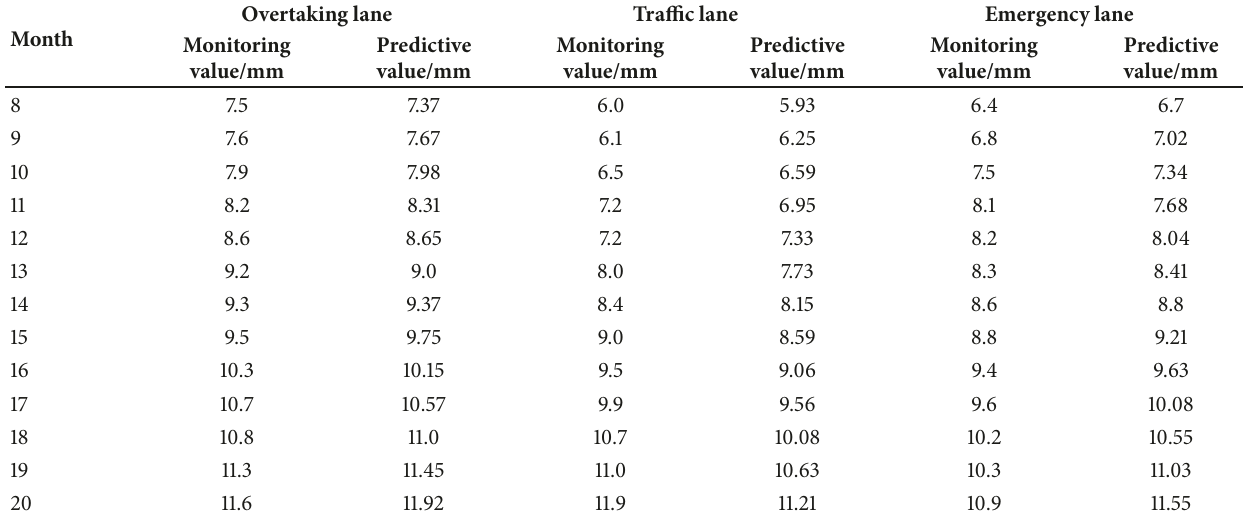
Table 3: The monitoring value and the predictive value of smoothness of each lane.